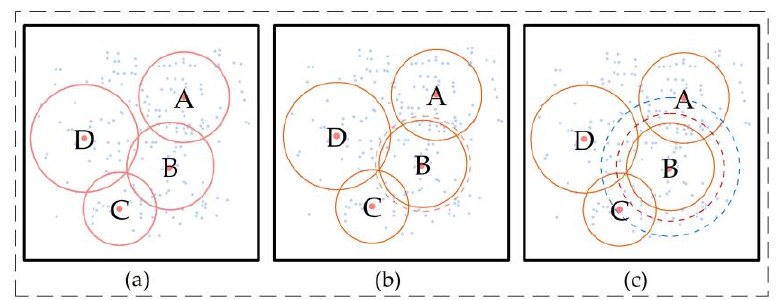
Figure 4. Adjusting shelter B’s catchment area based on its crowdedness and the average crowdedness of its slave shelters. ( a ) The catchment areas before adjusted; ( b ) Adjusting the catchment area of shelter B based on the second row of Equation (3); ( c ) Adjusting the catchment area of shelter B based on the third rows of Equation